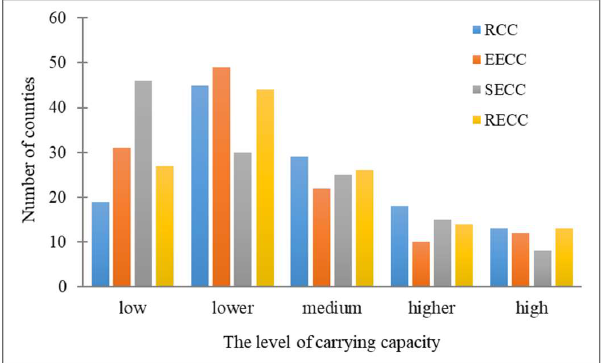
Figure 8. Number of counties at different levels of RCC, EECC, SECC, and RECC in Henan Province.